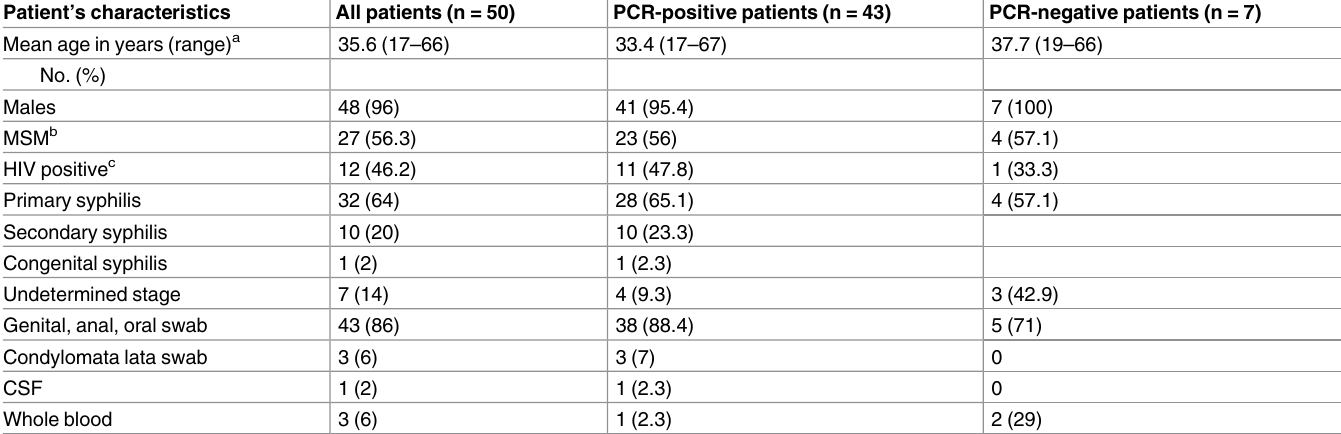
Table 1. Characteristics of 50 patients enrolled in this study during 2006and 2013 in Buenos Aires, Argentina.